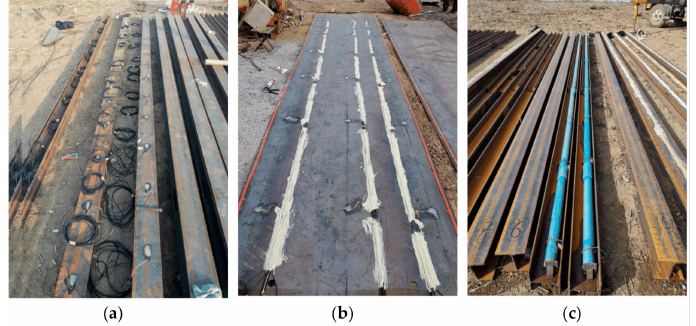
Figure 4. The layout of ( a , b ) stress and ( c ) horizontal displacement monitoring points.